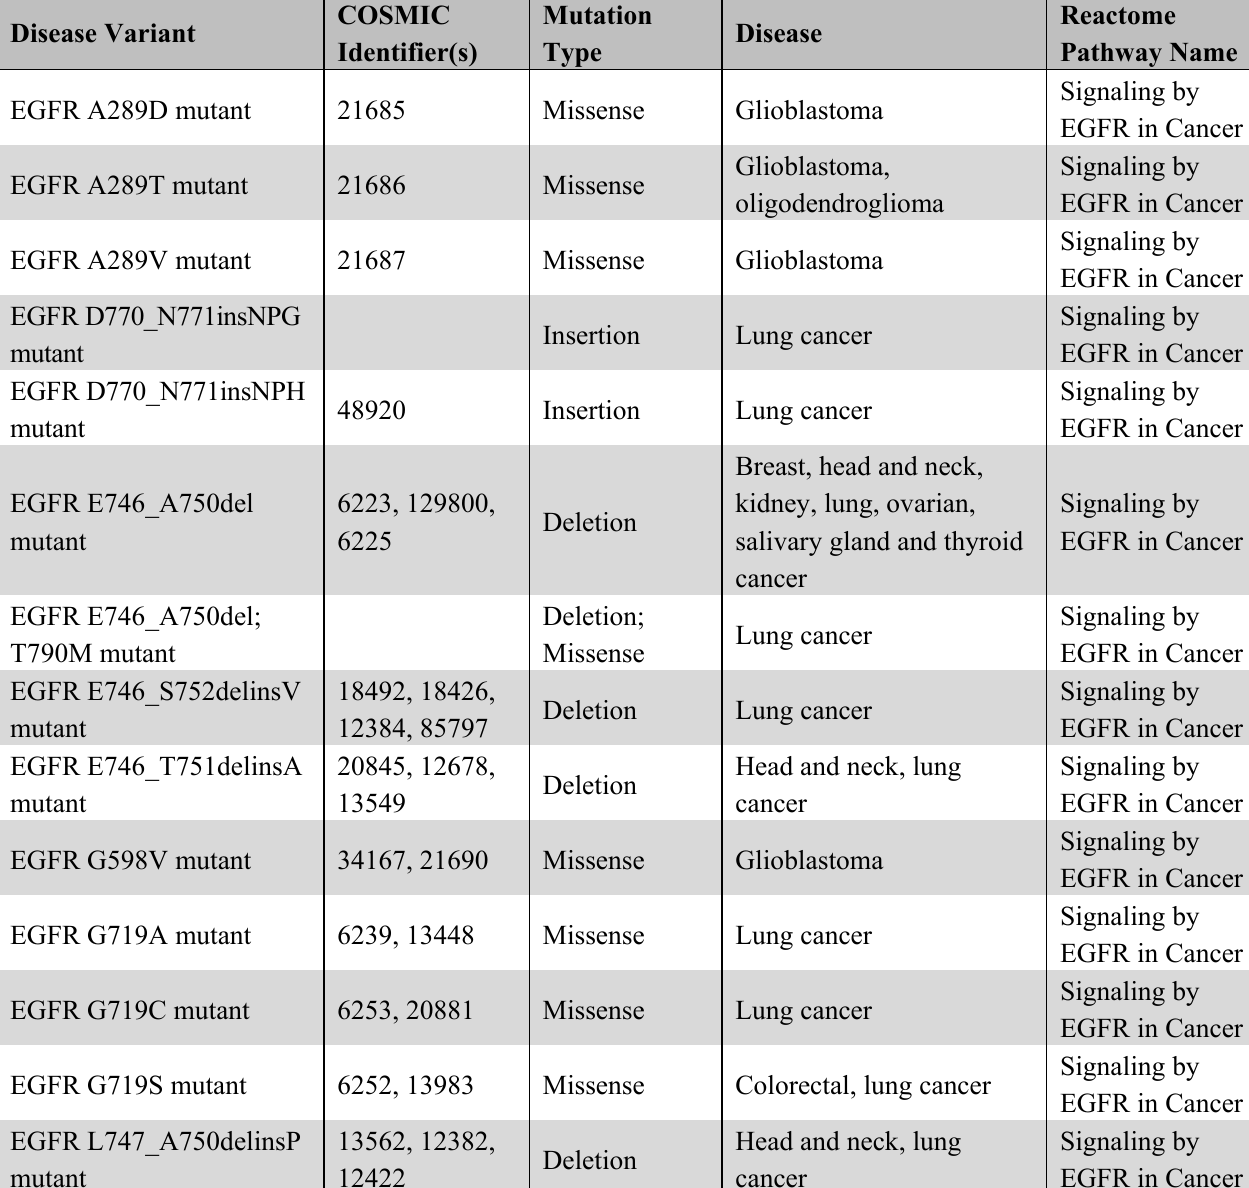
Table 1. Cancer-related disease variants published by Reactome to date. A total of ~150 cancer mutants have been published since the start of the project in December